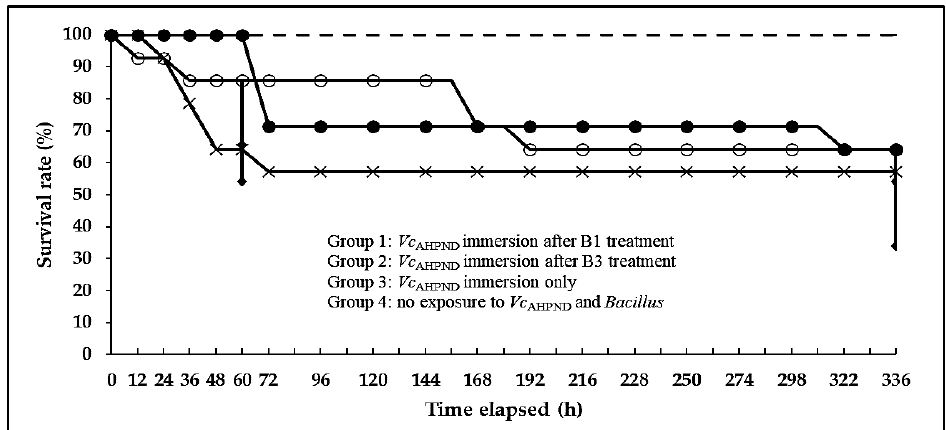
Figure 1. The survival rates (%) of Pacific white leg shrimp challenged with Vc AHPND (16-904/1). Table 4. The survival rates (%) of Pacific white leg shrimp at 60 and 336 h after Vc AHPND (16-904/1) immersion.